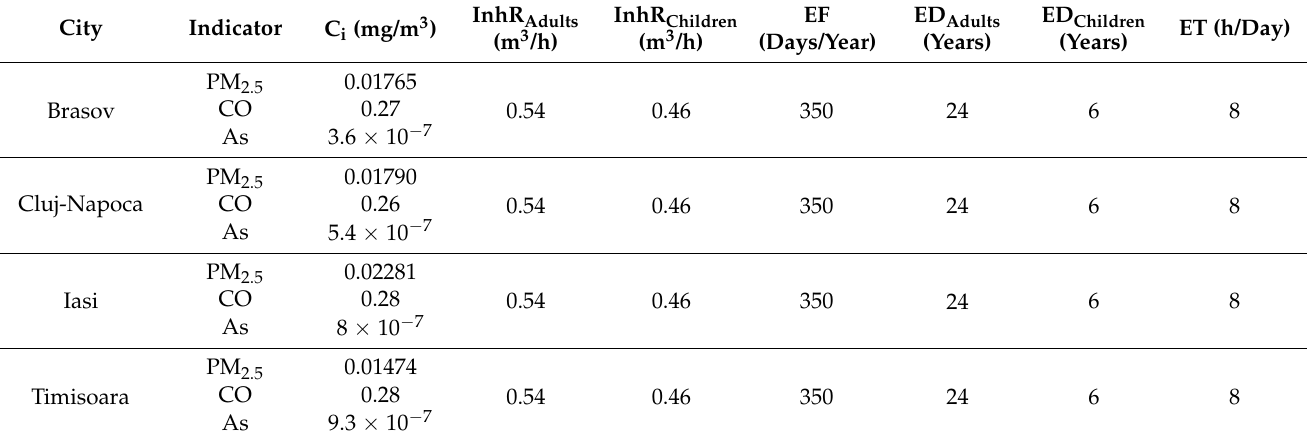
Table 5. Specific values for the calculation of the health risk